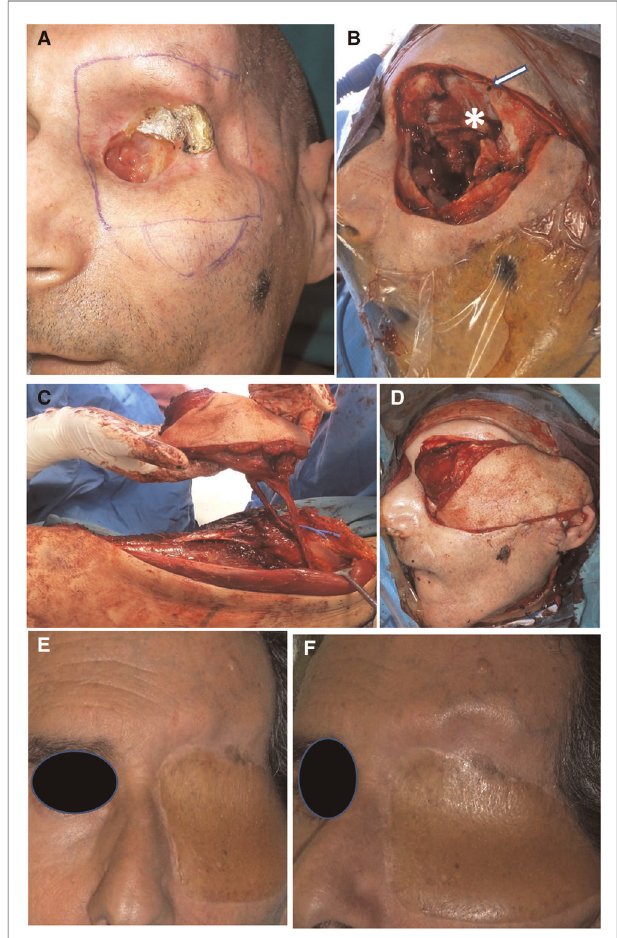
FIGURE 4 | Orbital and skullbase resection and reconstruction. ( A ) Patient presenting with SCC remnant of orbital roof postradiation therapy and osteoradionecrosis. ( B ) Wide resection of the left orbit. Basofrontal dura is marked with (asterisk); dura suspension sutures (white arrow). ( C ) Chimeric ALT fl ap harvesting with vastus lateralis component. ( D ) Flap insetting and fi lling of the paranasal cavities with a vascularized muscle. ( E, F ) Frontal and side views of the fi nal outcome at a 3-month